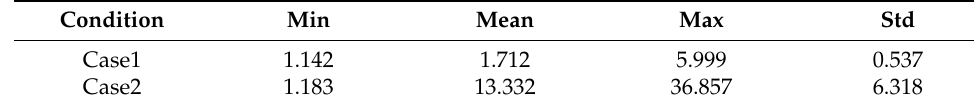
Table 4. Statistics of ICODM threshold (m).